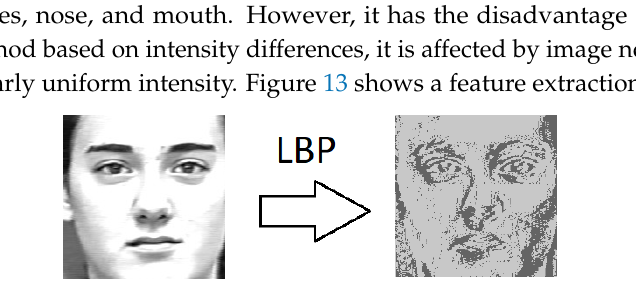
Figure 13. Feature extraction using LBP on a face from the CK+